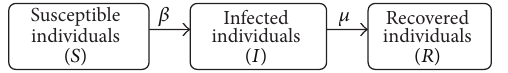
Figure 1: The scheme of the susceptible-infected-recovered model